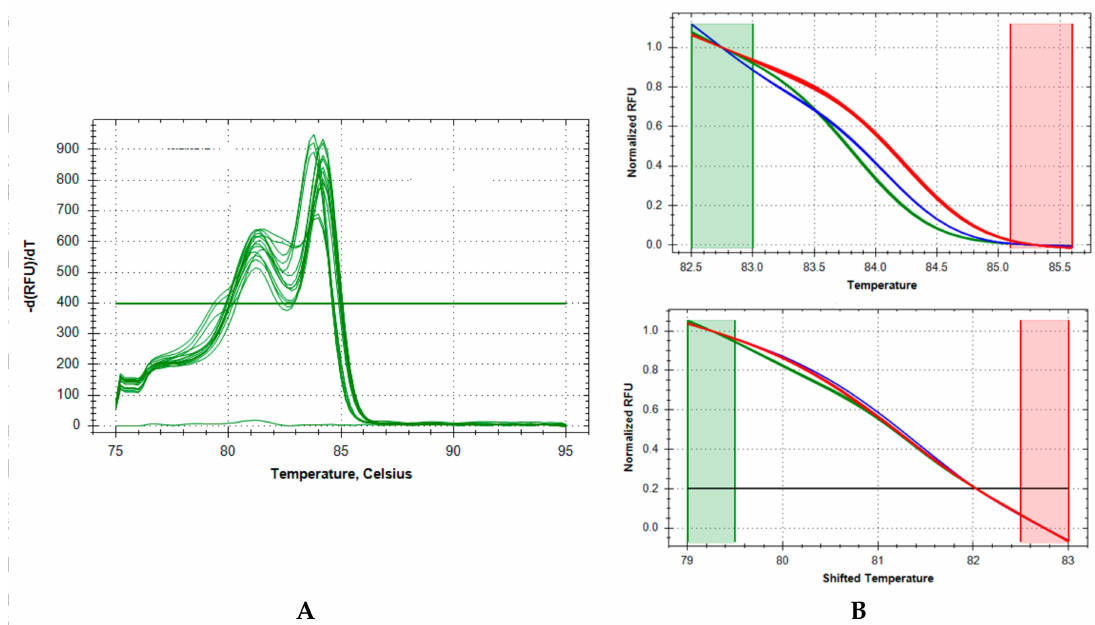
Figure 1. Negative First Regression Adjusted Raw Fluorescent Data of Amplified Products. In Panel A the peaks of ZAP70 * and IKBKB # represent the melting temperatures of all the ZAP70 and IKBKB amplicons where there is 50% loss of fluorescent signal intensity, that is, the point at which one half of the double stranded amplicon DNA is denatured. The rate of change in fluorescence as the temperature rises is determined by plotting the negative first regression of relative fluorescence (RFU) vs. Temperature ( − d(RFU)/dT) on the y-axis. Panel B shows the results when the Precision Melt Analysis software normalized the raw fluorescent data ( A ) and set pre- and post-melt signals to relative values of 1.0 to 0. The normalized melt curves produced were distinct for the ZAP70 amplicons ( Top B ) and the IKBKB amplicons ( Bottom B ).